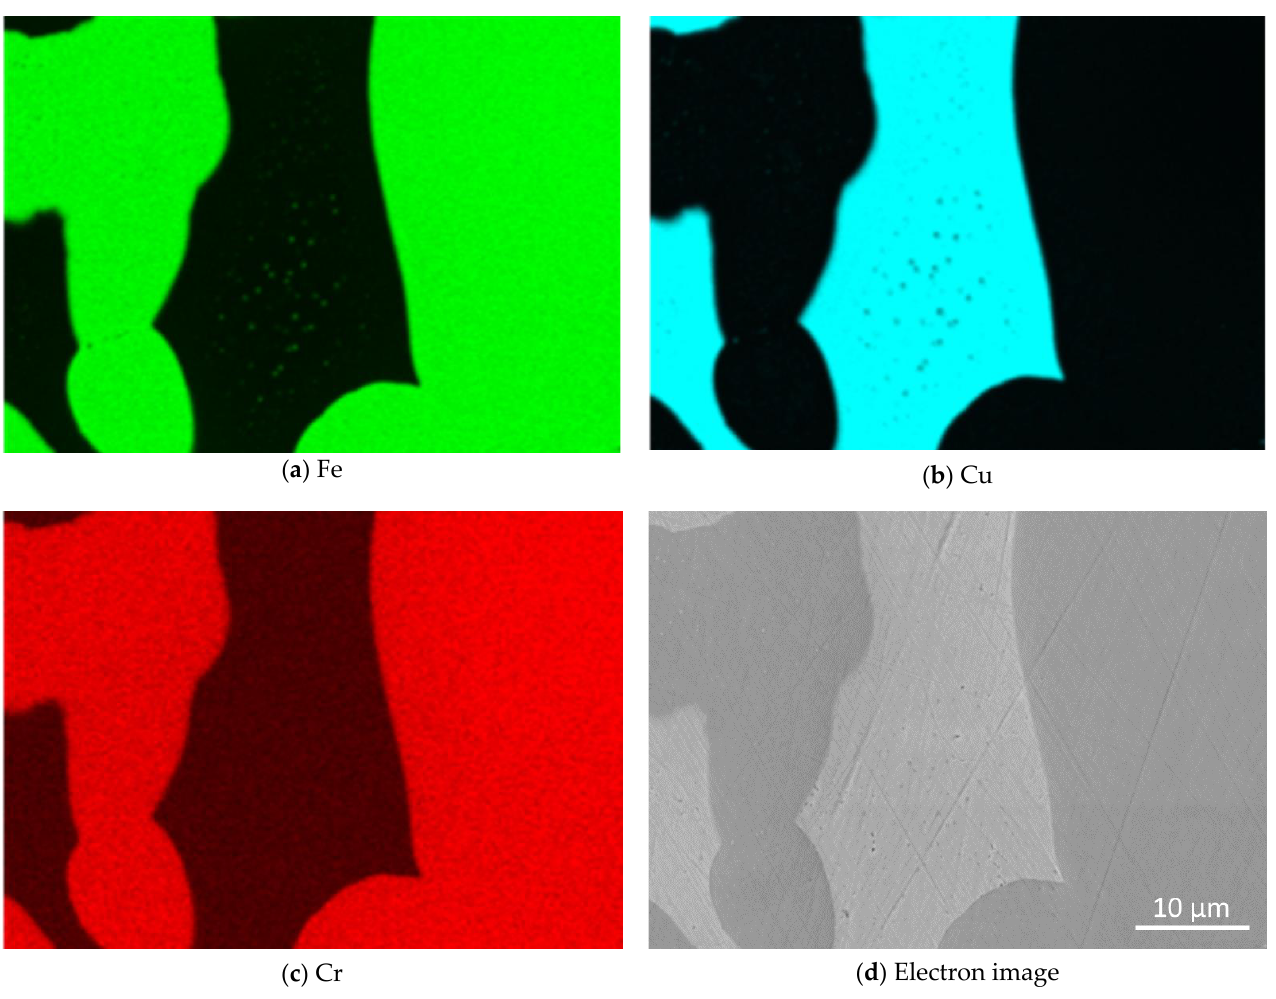
Figure 6. EDS images of the H11/Cu composite material with 15 wt.% of fine H11 powder showing the elemental distribution of ( a ) Fe, ( b ) Cu and ( c ) Cr as the alloying element with the highest con- centration in H11; ( d ) the electron image.